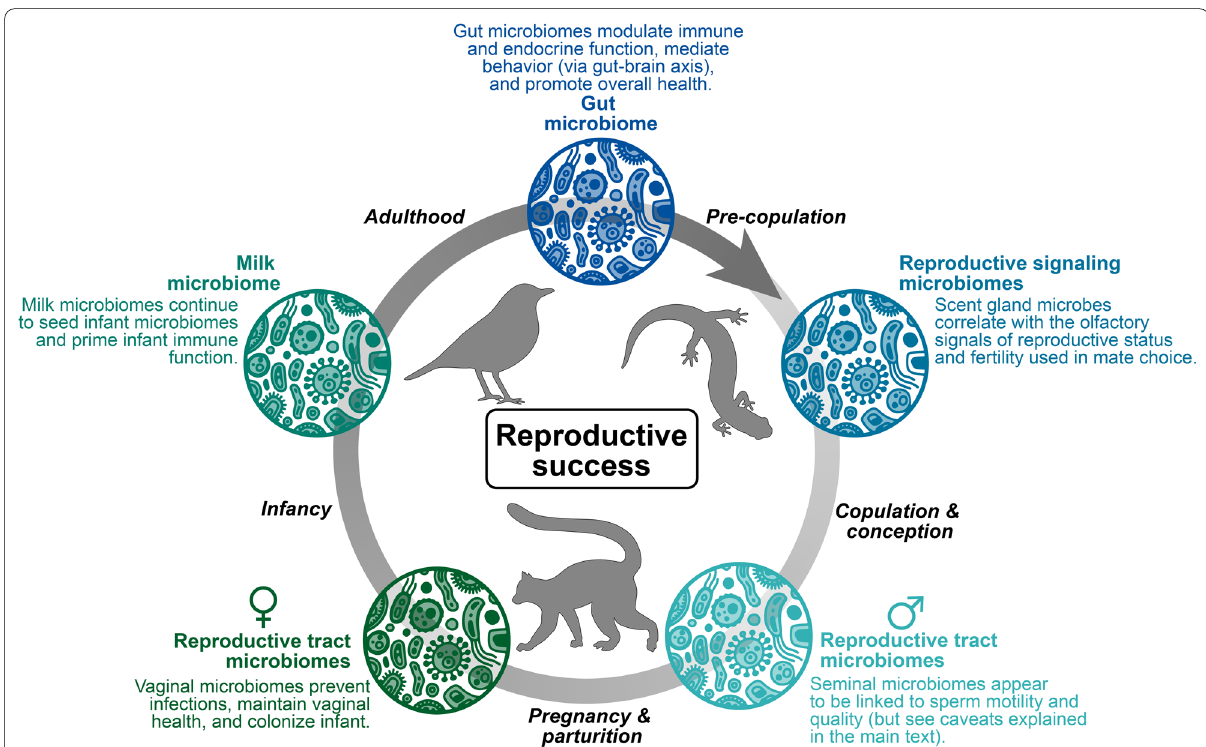
Fig. 1 interactions between host microbiomes, life cycles, and reproductive success in wild animal